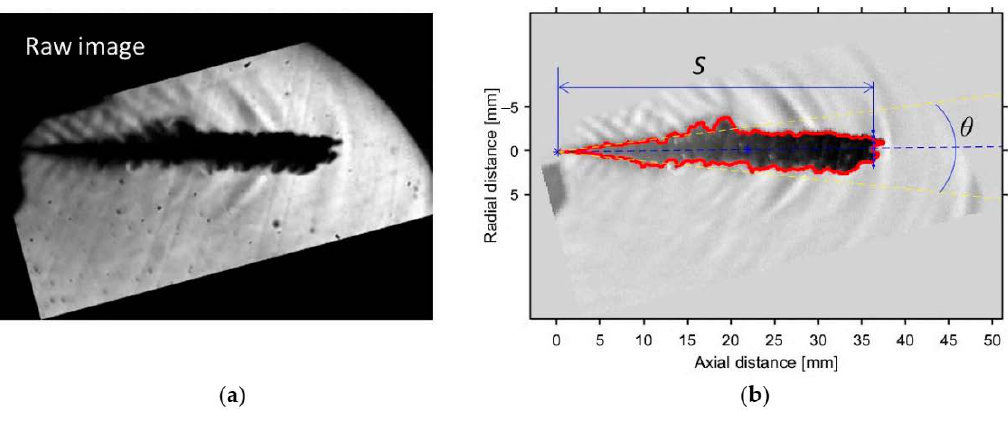
Figure 5. Definition of spray tip penetration ( S ) and spray angle ( θ ): ( a ) Raw image of spray; ( b ) definition of spray tip penetration and spray